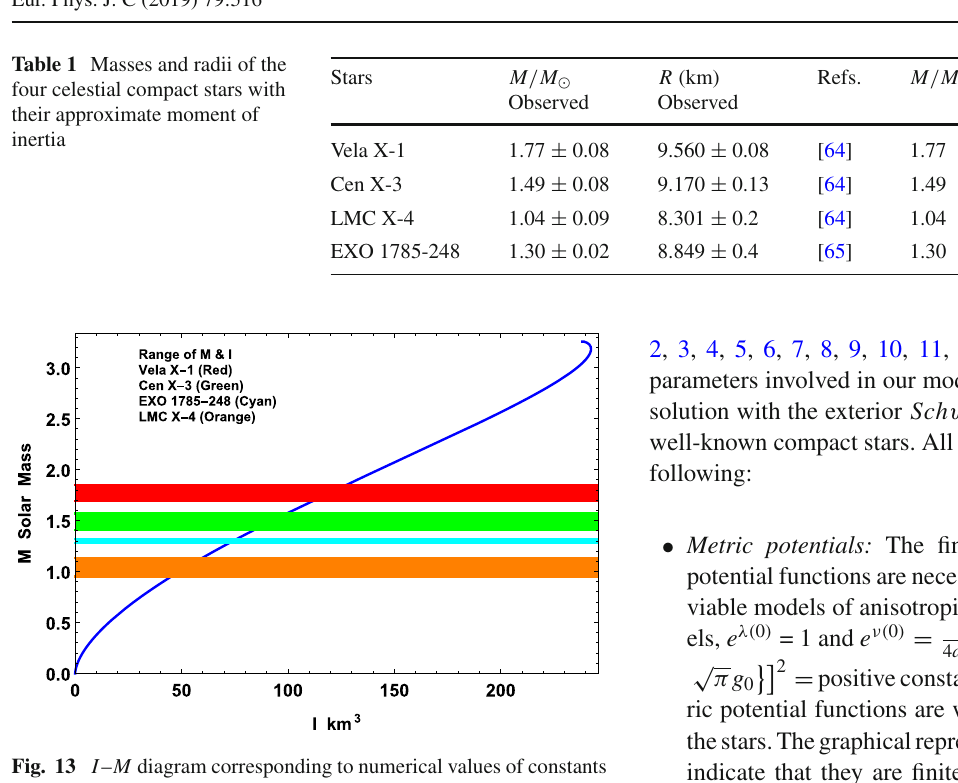
Fig. 13 I – M diagram corresponding to numerical values of constants given in Table 2 for four well-known compact stars Table 2 Numerical values of constants for the four celestial compact stars